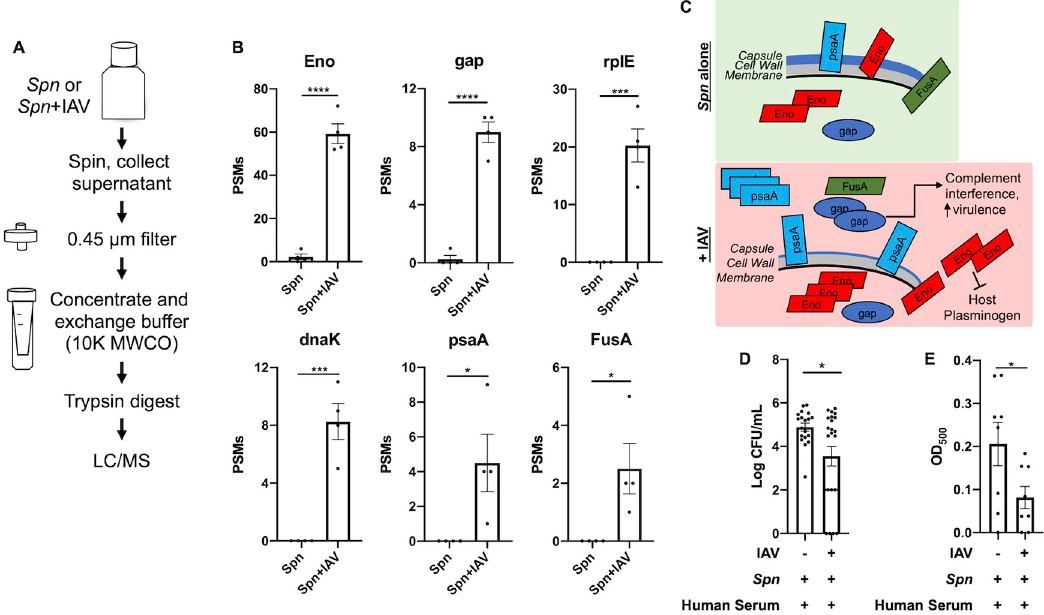
Fig 4. Release of Spn surface proteins was increased in the presence of Influenza virus and promotes complement inhibition. ( A ) Workflow for the collection and processing of extracellular Spn proteins for LC/MS analysis. ( B ) PSM count of extracellular Spn proteins in the presence or absence of IAV (Data reflect n = 4 presented as mean ± SD, Two-tailed Student’s t-test, � p < 0.05, ��� p < 0.001, ���� p < 0.0001). Eno, enolase; RplE, 50S ribosomal protein L5; GAP, Glyceraldehyde-3-phosphate dehydrogenase; dnaK, Chaperone protein; PsaA, Manganese ABC transporter substrate-binding lipoprotein; FusA, Elongation factor G. ( C ) Schematic model of the proposed IAV-induced Spn pathway changes that lead to enhanced host invasion and inhibition of complement. ( D ) Recovered Spn (CFU/ml) in phagocytosis assay. ( E ) Complement-driven hemolysis assay in red blood cells challenged with Spn Δ ply. Student t test, asterisks denote the level of significance observed: � = p � 0.05; �� = p � 0.01; ��� = p �